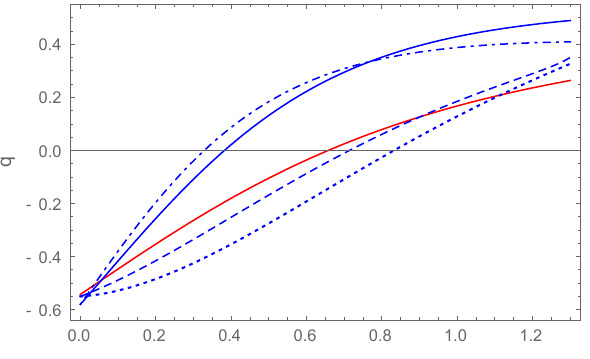
Figure 3. Variation of the deceleration parameter, q , as a function of z for K µν = ( β 2 R + γ 2 T ) R µν with different values of the parameters b 2 and g 2 : b 2 = 0.044 and g 2 = − 0.01 (solid curve), b 2 = − 0.0076 and g 2 = 0.001 (dotted curve), b 2 = − 0.013 and g 2 = − 0.0007 (dashed curve), and b 2 = 0.013 and g 2 = 0.03 (dot-dashed curve) The evolution of the deceleration parameter in the standard Λ CDM model is depicted by the red solid